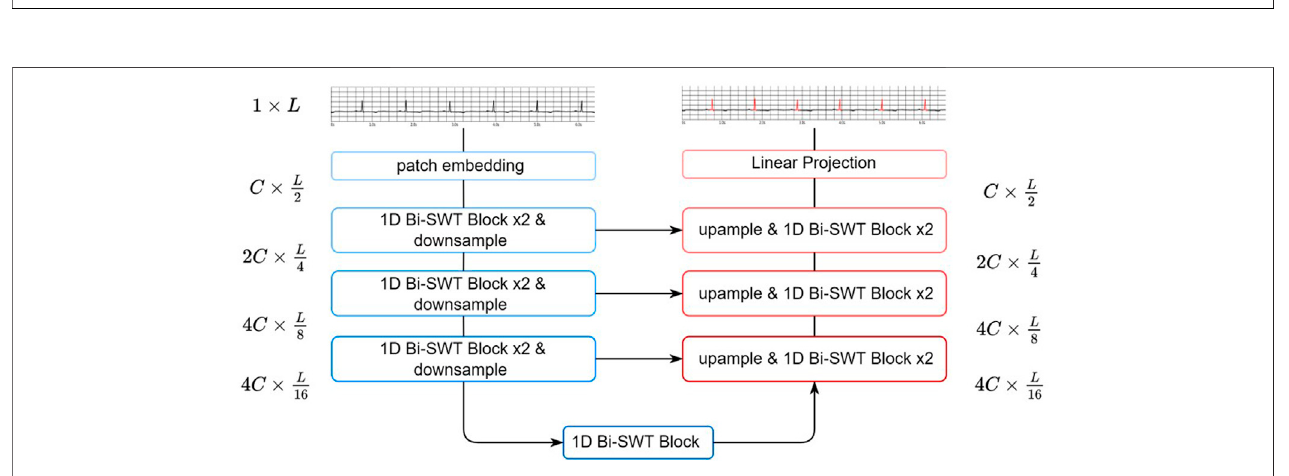
FIGURE 1 | Schematic work fl ow of diagnosing ST-segment depression and elevation, and J point elevation from Holter electrocardiogram signal.